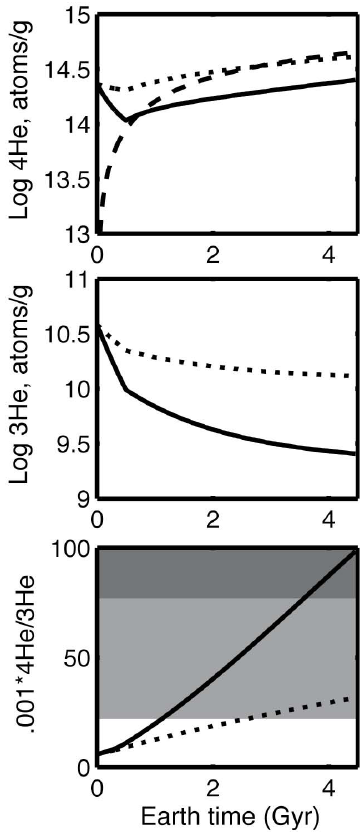
Fig. 19. An indicative calculated evolution of helium isotope con- centrations and ratios. MORB source: solid curves; unradiogenic OIB source: short-dashed; radiogenic production: long-dashed. The degassing rate is assumed to have been 3 times higher dur- ing the first 0.5Gyr. Dark grey: observed MORB range; light grey: observed OIB range. The MORB source calculation assumes a residence time of about 1.5Gyr, whereas the unradiogenic OIB source residence time is assumed to be 2.5 times greater, i.e. about 3.75Gyr. From Davies (2010). Copyright American Geophysical